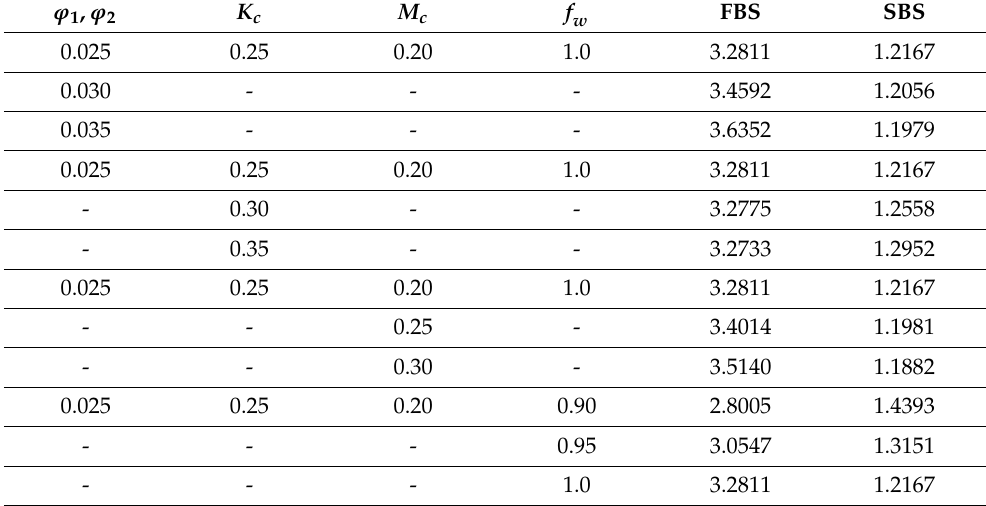
Table 4. Quantitative values of SSC for the several distinct parameters when ε c = − 1.5, γ c = −